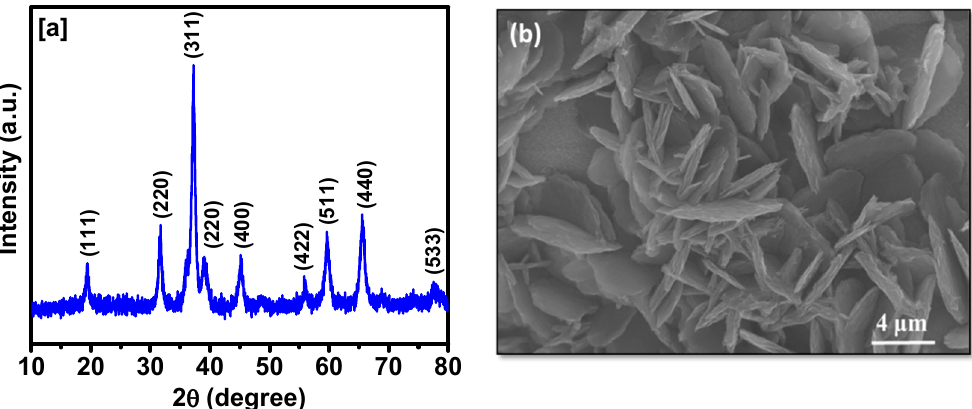
Figure 2. ( a ) XRD pattern and ( b ) SEM image of CuCo 2 O 4 .